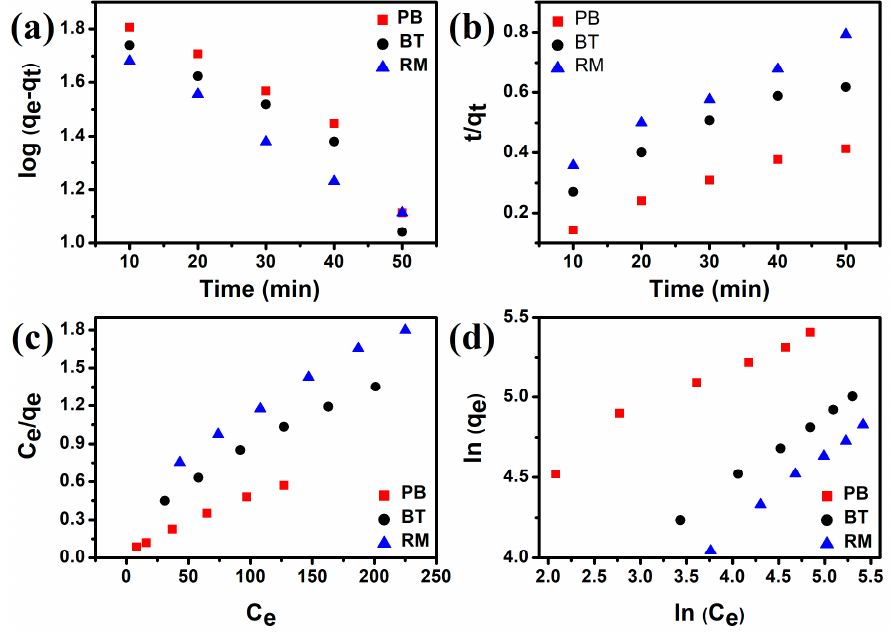
Figure 13. ( a ) Pseudo-first-order and ( b ) pseudo-second-order kinetic models; ( c ) Langmuir isotherm and ( d ) Freundlich isotherm model for MG adsorption onto NICs adsrobents. Table 4. Langmuir and Freundlich parameters for the adsorption of MG onto NICs adsorbents. Table 3. Kinetic data predicted by pseudo-first-order and pseudo-second-order kinetic models for the adsorption of MG onto NICs adsorbents. Adsorbent Pseudo-First Adsorbent